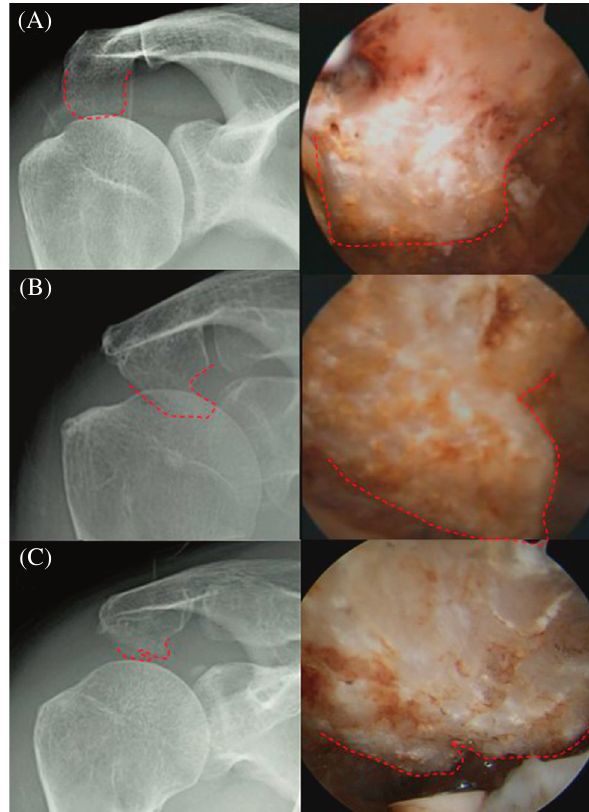
Figure 4. The example of the ‘‘at-risk spur’’ from arthroscopic classification compared to the Rockwood film. (The heel spur is in inset (A), the keel spur is in inset (B), and the irregular spur is in inset (C)).